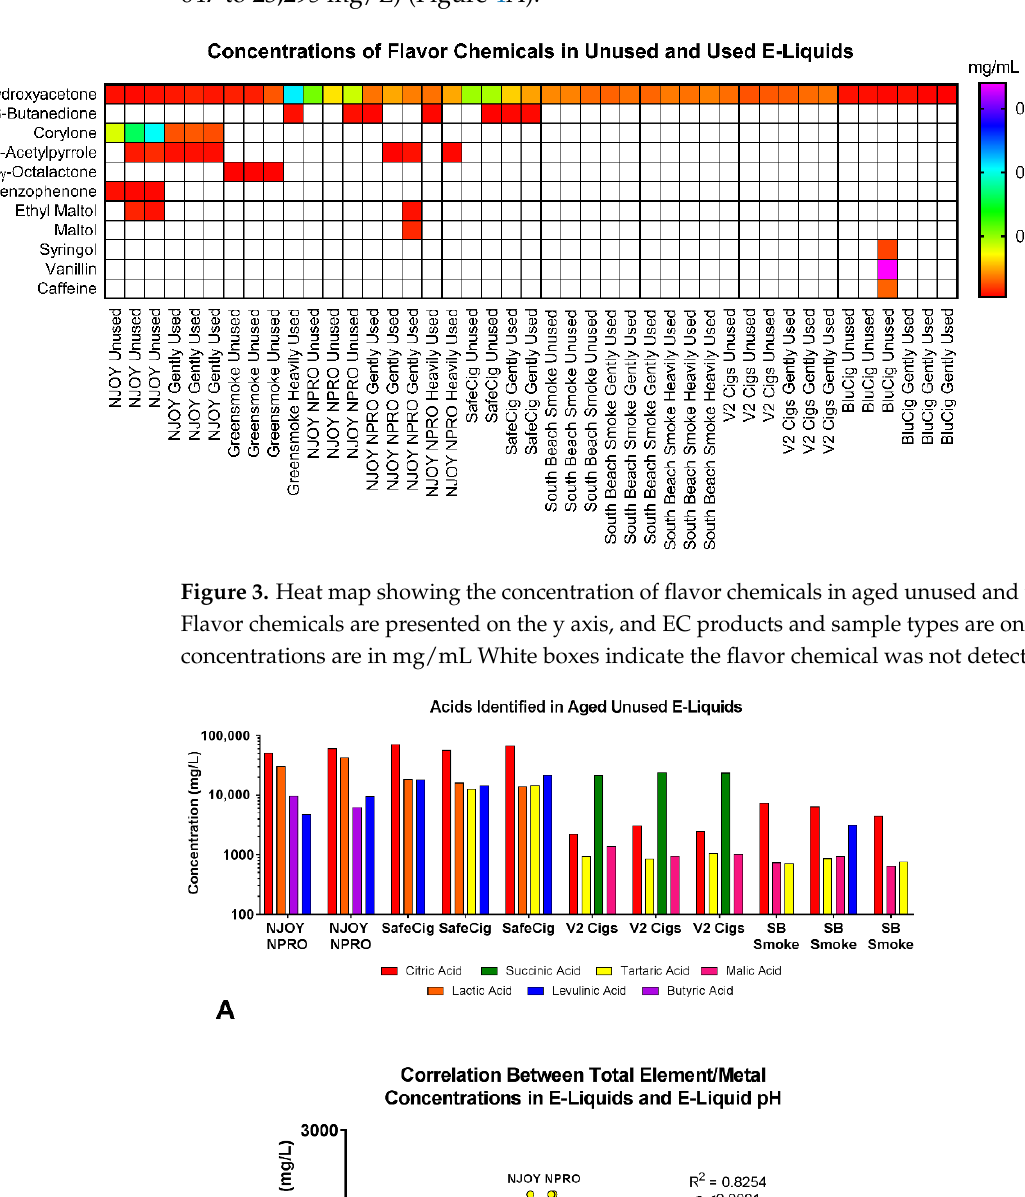
−5 1 a Color gradient: green indicates lowest percent difference between labeled and measured, while red indicates highest percent difference. A total of 33 flavor chemicals were identified in 10 brands of aged unused and used